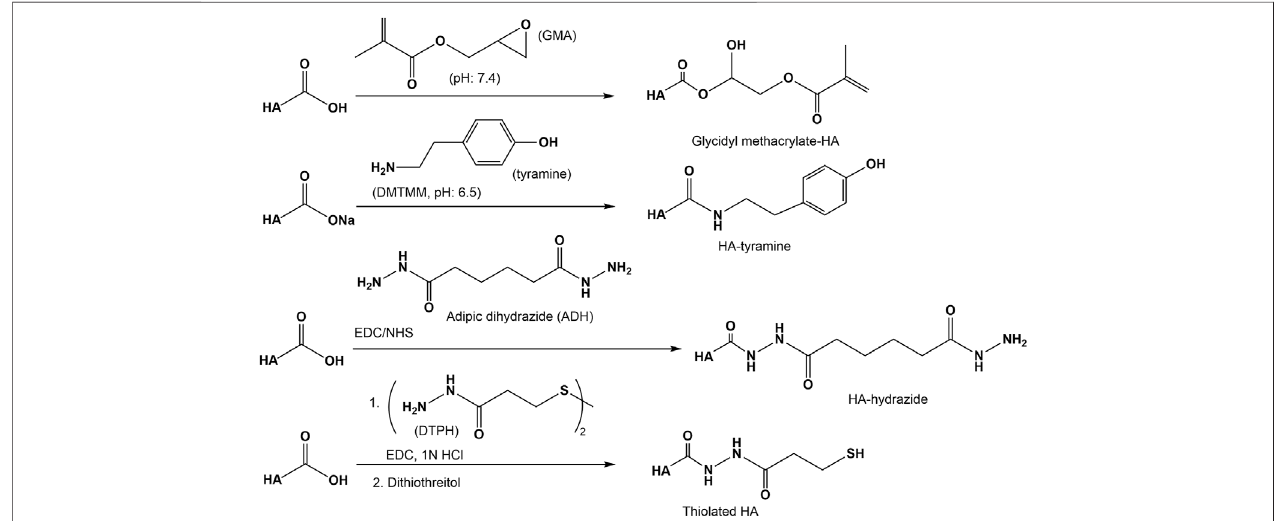
FIGURE 10 | Reactions of the HA carboxyl group with epoxides, amines, and hydrazides.